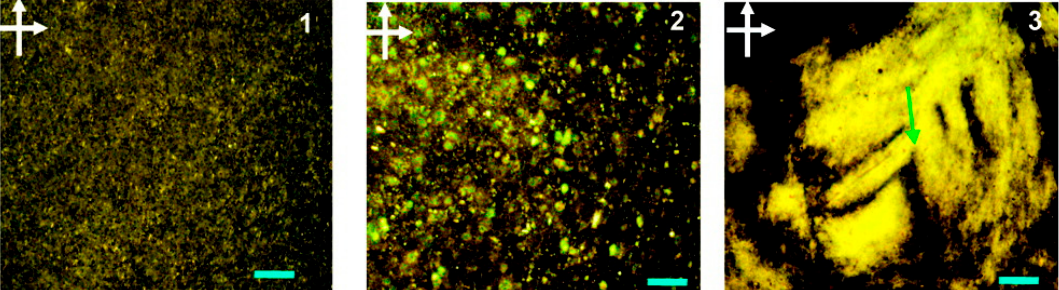
Figure 4. Polarized optical microscopy (POM) images of graphene oxide dispersions increasing in concentration from the isotropic phase (1 − 5 × 10 − 4 f m , where f m is the mass fraction of GO in the dispersion) through the biphasic region in which small clusters of birefringent domains can be seen (2–1 × 10 − 3 f m ) and then to the nematic phase (3–3 × 10 − 3 f m ). The scale bar represents 200 µ m. The arrow in the third image indicates the boundary between two nematic domains. This appears as a dark brush in polarized microscopy, analogous to the Schlieren textures of thermotropic nematic liquid crystals. Reprinted with permission from Xu and Gao [12]. Copyright (2011) American Chemical Society.